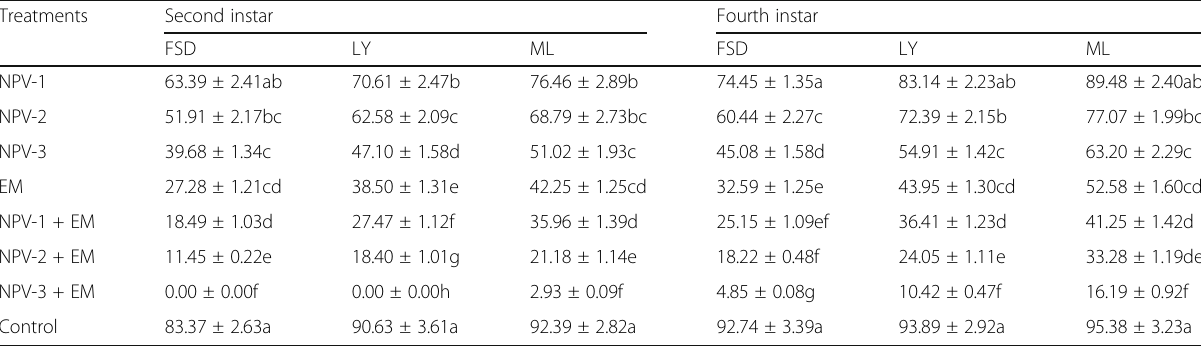
(Table 2). Adult emergence and egg eclosion of both in- stars were found inversely related to pathogenicity of NPV and emamectin benzoate. Significant differences Table 4 Mean egg eclosion (%±SE) of second and fourth larval instars of Spodoptera litura from three different field populations treated with nucleopolyhedrosis virus and emamectin benzoate. (NPV-1 2 × 10 9 POBs ml − 1 , NPV-2 3 × 10 9 POBs ml − 1 , NPV-3 4 × 10 9 POBs ml − 1 , EM 0.1 ppm)